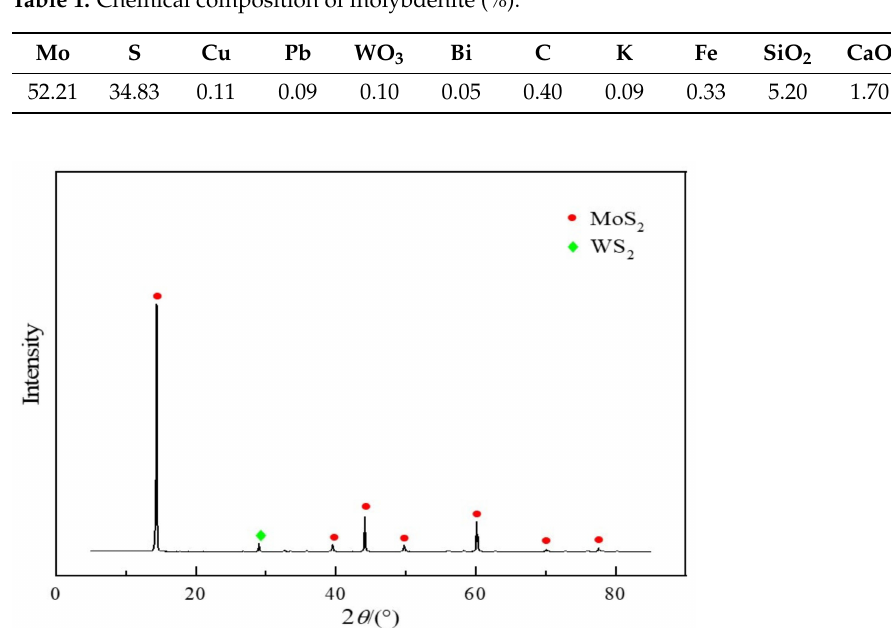
Table 1. Chemical composition of molybdenite (%).